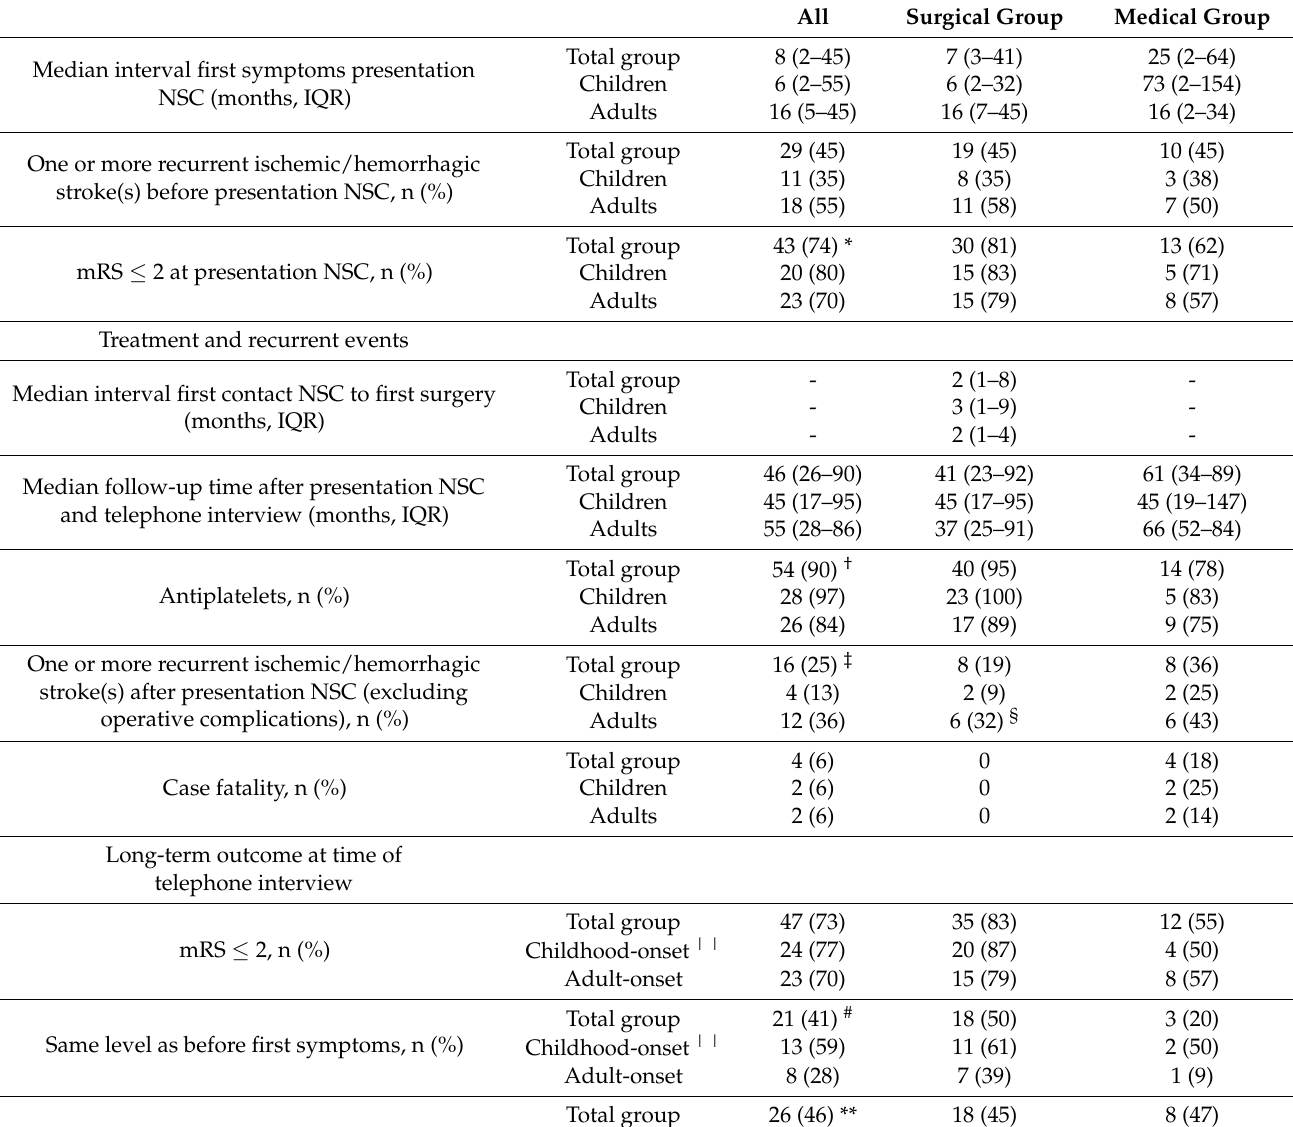
Table 2. Outcome of 64 patients with moyamoya